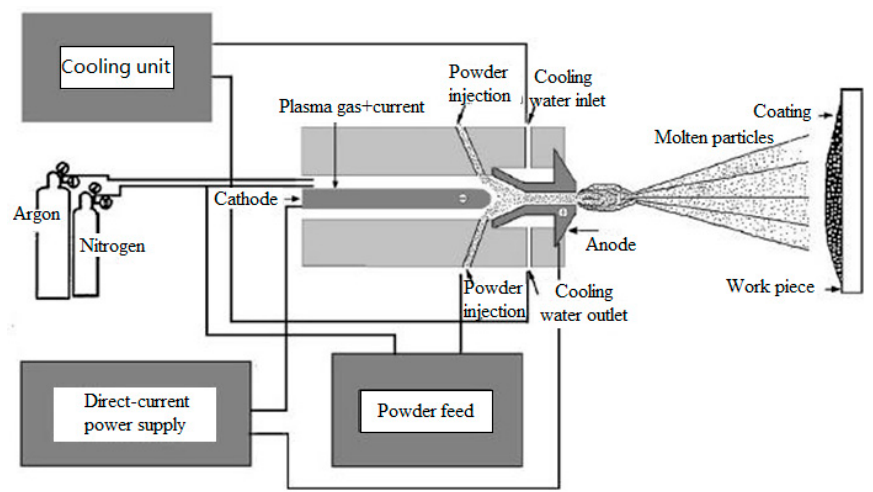
Figure 5. Schematic diagram of plasma spraying [43]. Reprinted with permission from reference [43] 2012 Elsevier.